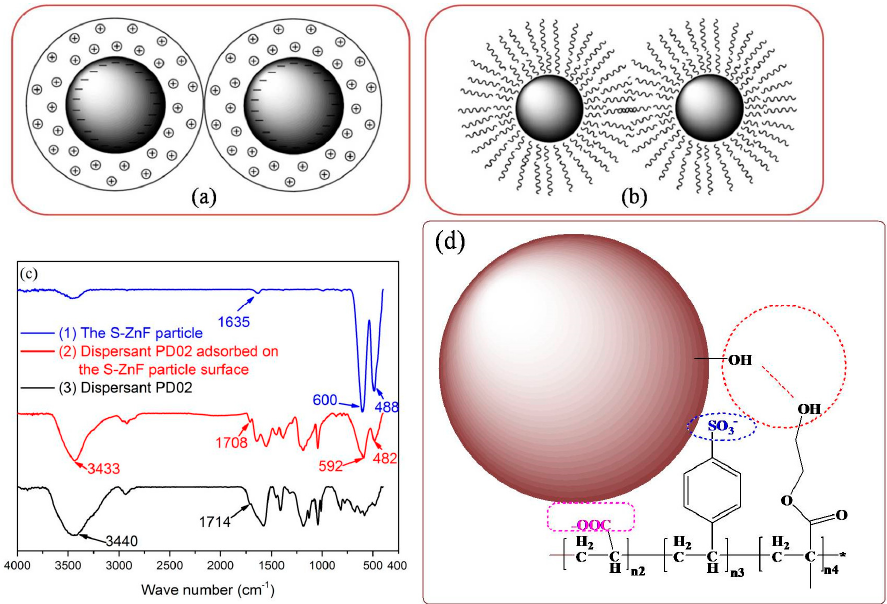
Figure 12. ( a ) Electrostatic repulsion between particles; ( b ) Steric hindrance between particles; ( c ) the FTIR spectra of dispersant PD02 adsorbed on the S-ZnF particle surface; ( d ) The schematics of dispersant PD02 adsorbed on the S-ZnF particle surface.